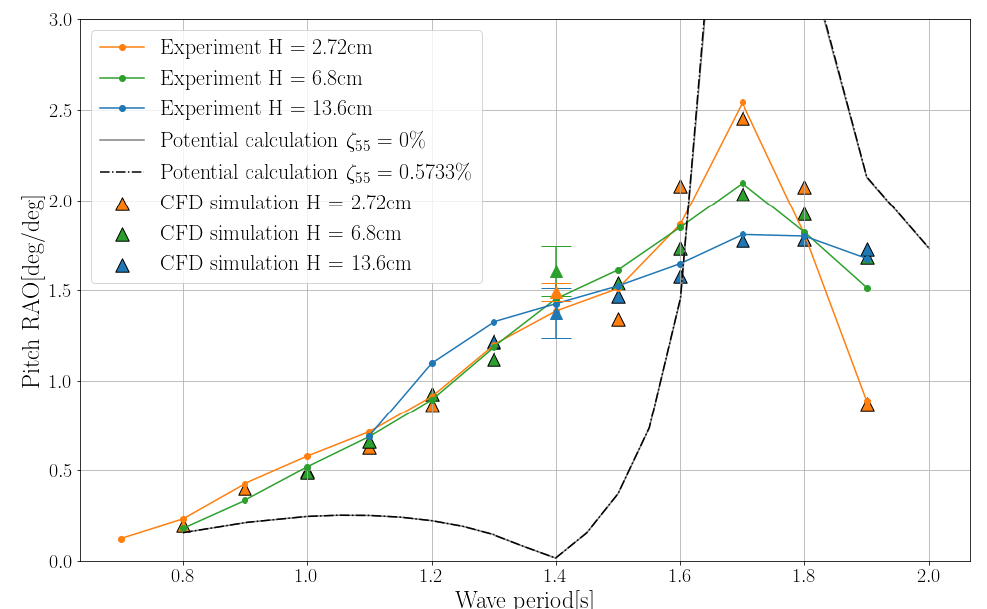
Figure 18. RAO of the pitch motion of the floater in